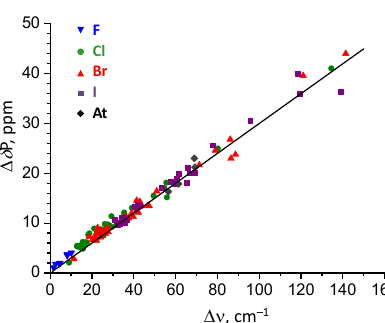
Figure10. CorrelationbetweenthechangeoftheP = Ostretchingvibrationfrequencyuponcomplexation, ∆ ν , and the change of the 31 P NMR chemical shift upon complexation, ∆ δ P, for R–X ··· O = PMe 3 halogen-bonded complexes studied in this work (X = F, Cl, Br, I, At). The solid line corresponds to Equation (10). R 2 (coefficient of determination) of the fitted line equals to 0.993.